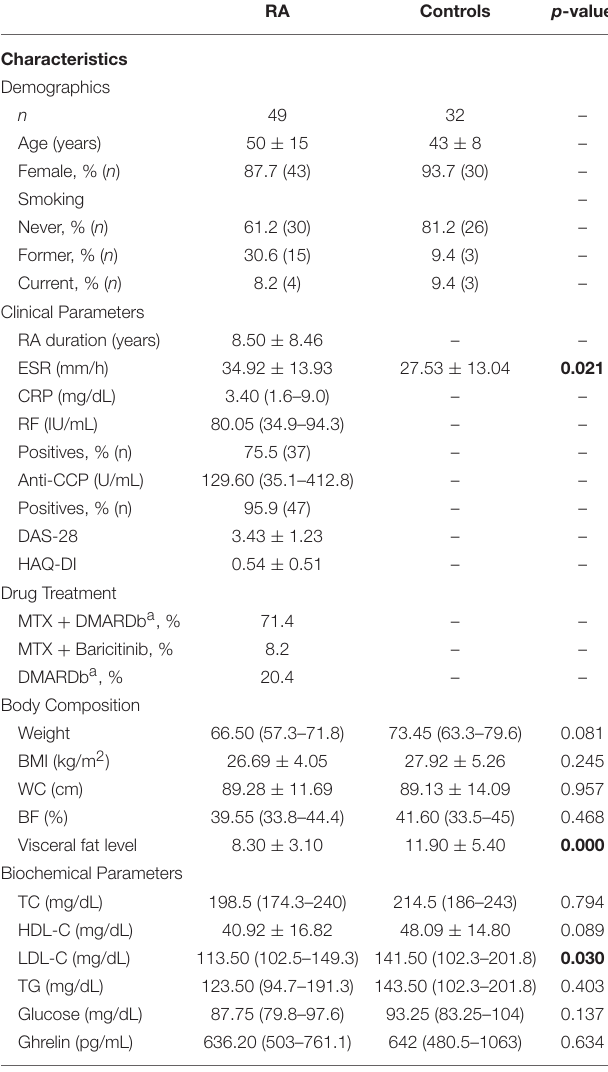
TABLE 1 | Demographic, body composition, biochemical, and clinical